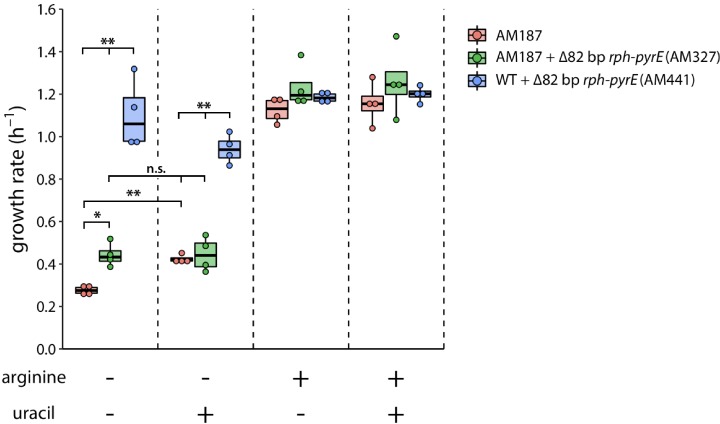
Effects of arginine (5.2 mM) and uracil (0.2 mM) on growth rates of AM187, AM327 and AM441.Concentrations of arginine and uracil were chosen based on those in EZ rich defined medium (Neidhardt et al., 1974). *, p value < 0.01. **, p value < 0.005; n.s. indicates not significant based on a two-tailed, unequal variance Student’s t-test, N = 4.